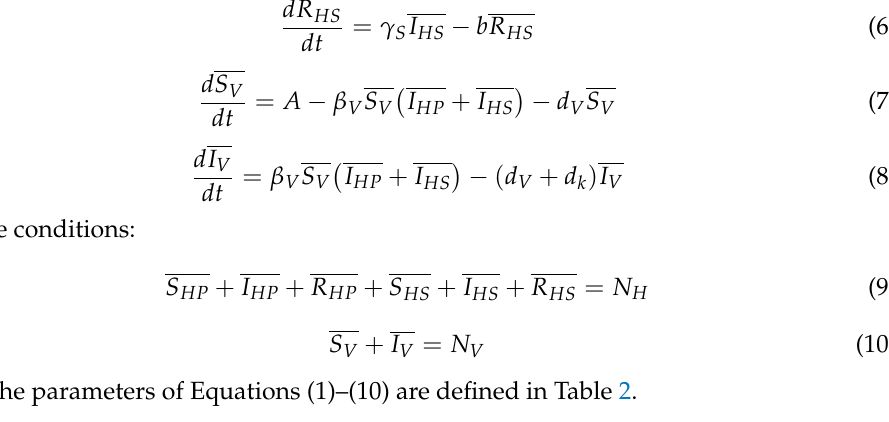
Table 2. The definition of the parameters of the differential system of Equations (1)–(10). Parameters Definition α The biting rate of the vector population ψ The vaccine efficiency The recurrent infection rate The total number of humans in the study population The total number of vectors in the study population The transmission rate of dengue virus from vector to human The transmission rate of dengue virus from human to vector The birth and natural mortality rate of the human population The natural mortality rate of the vector population d d The mortality rate from infection of the human population d k The mortality rate from infection of the vector population γ P The recovery rate of those with a primary infection γ S The recovery rate of those with a secondary